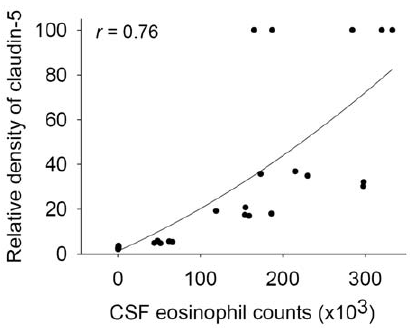
Figure 4. Correlation between claudin-5 and Evans blue. The claudin-5 levels were significantly correlated ( r =0.95; P , 0.05) with Figure 5. Correlation of claudin-5 with CSF eosinophils. The level of claudin-5 was correlated significantly ( r =0.76; P , 0.05) with CSF eosinophil count, using Spearman’s ranking correlation